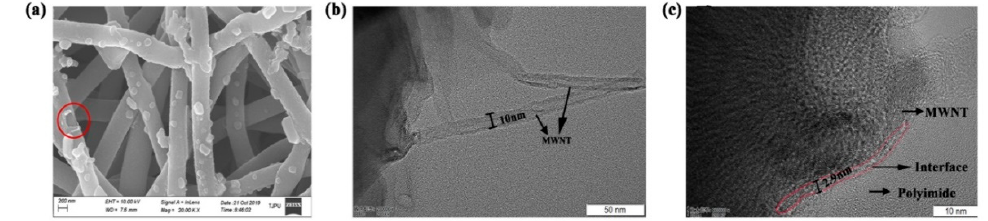
Figure 7. Diagram of MWNT/PI nanocomposites of ( a ) a MWNT wrapped in PI long molecular chains in a period and ( b ) the cross section of nanocomposite when X-ray incident from the side direction.